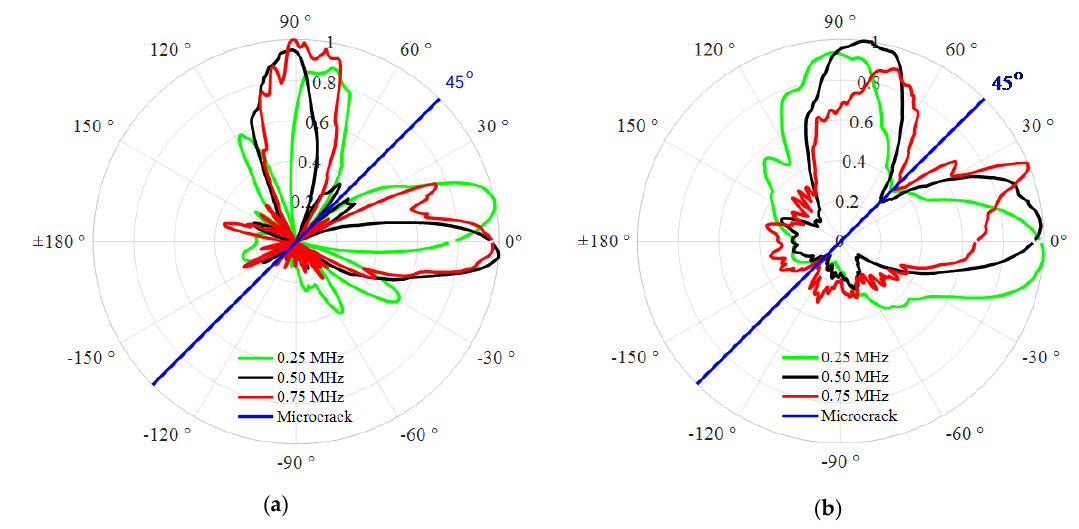
Figure 8. Normalized directivity of the radial ( a ) and circumferential ( b ) second harmonic amplitudes under the UTW driving frequency of 0.25, 0.5 and 0.75 MHz.